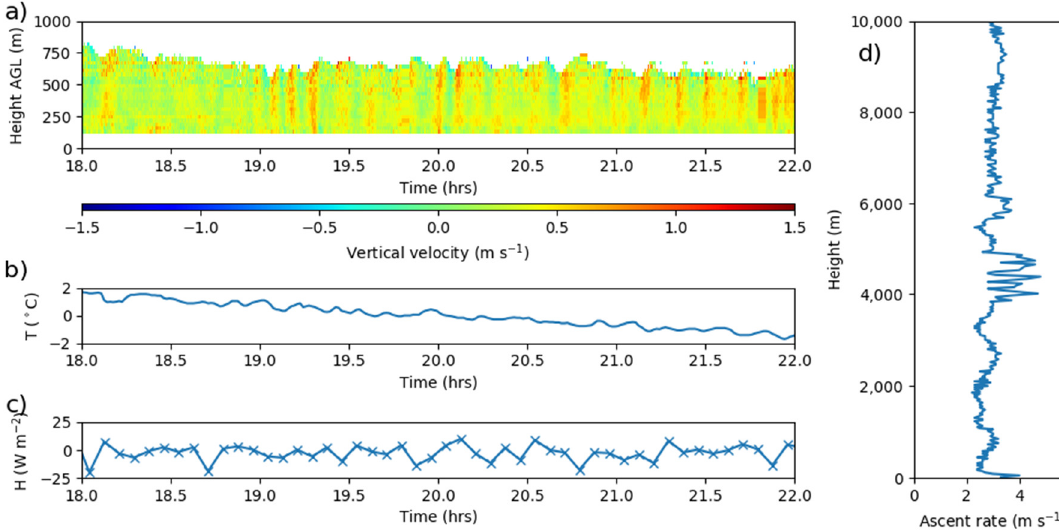
Figure 6. Observations of vertical velocity from lidar ( a ), 1.2 m temperature at 1 min intervals ( b ), 5-min average sensible heat flux at 50 m ( c ) and ascent rate from a radiosonde launch at 20:00 ( d ). All from 10 December 2009, during Intensive Observation Period (IOP) 10 of the COLPEX field experiment.